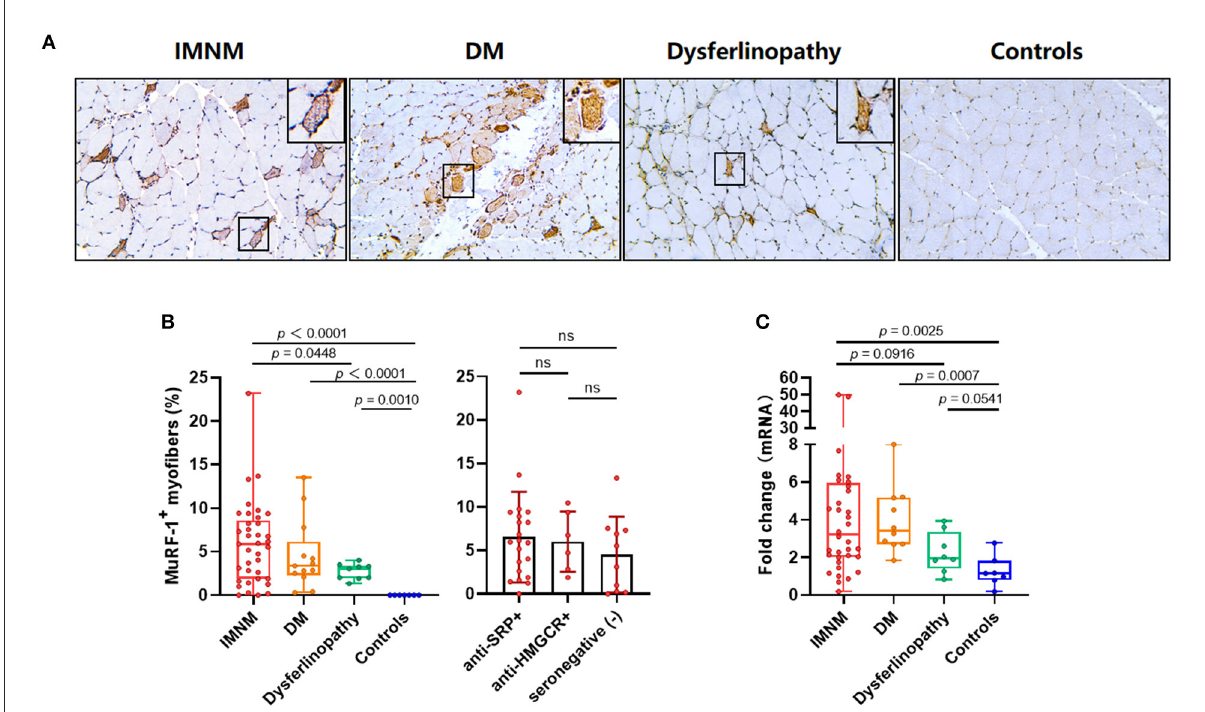
FIGURE1 Staining pattern of muscle RING finger-1 (MuRF-1) in muscle biopsies. (A) Positive MuRF-1 staining in muscle biopsies from IMNM and dysferlinopathy with a diffuse distribution, as well as DM with a perifascicular distribution. No MuRF-1 staining was found in control biopsies. Magnification: × 200. (B) High percentage of MuRF-1 positive myofibers in IMNM biopsies. (C) The mRNA expression of MuRF-1 in muscle biopsies from IMNM, DM, dysferlinopathy and